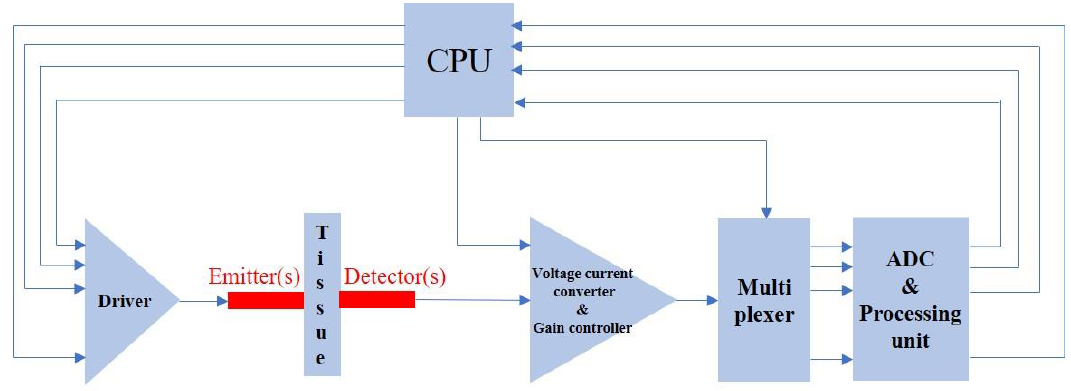
Figure 6. The assembly of a multiwavelength, multisource, multidetector fNIRS system.